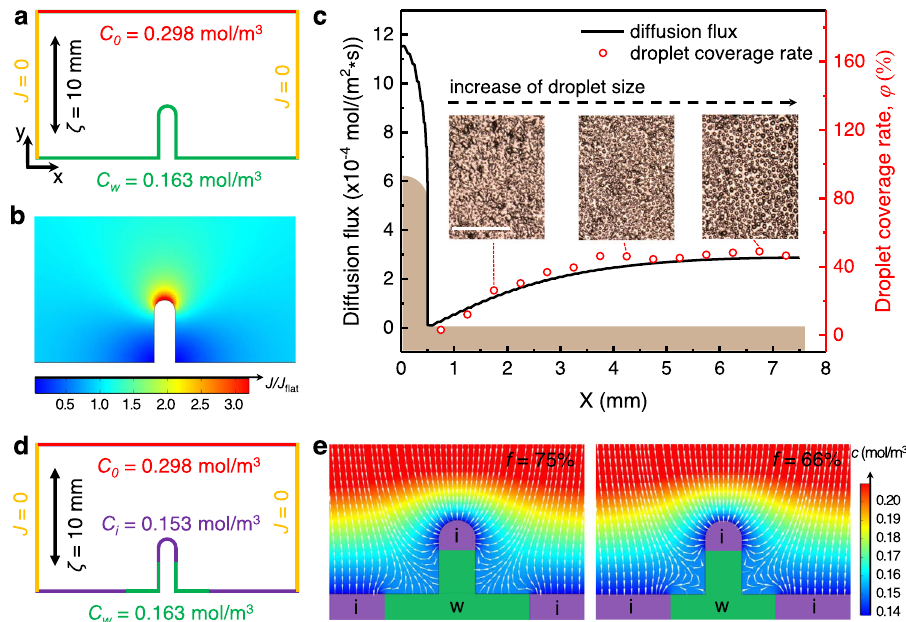
Fig. 2 Vapor diffusion over a macro-ridged surface during condensation frosting. a Boundary conditions for simulating condensation process. b Numerical calculation of the total vapor diffusion fl ux over the macro-ridged surface J normalized by that on a fl at surface J fl at at a steady state during condensation stage (Supplementary S3). c Distribution of vapor diffusion fl ux and the droplet coverage rate (Supplementary Fig. S5) on the macro-ridged surface. The insets show the corresponding micrographs related to the data points. Scale bar, 300 μ m. d Boundary conditions for simulating the droplet evaporation. e Diffusion fl ux on the macro-ridged surface H3D1.5 with f = 75% and 66%, respectively. The arrows indicate the directions of vapor fl